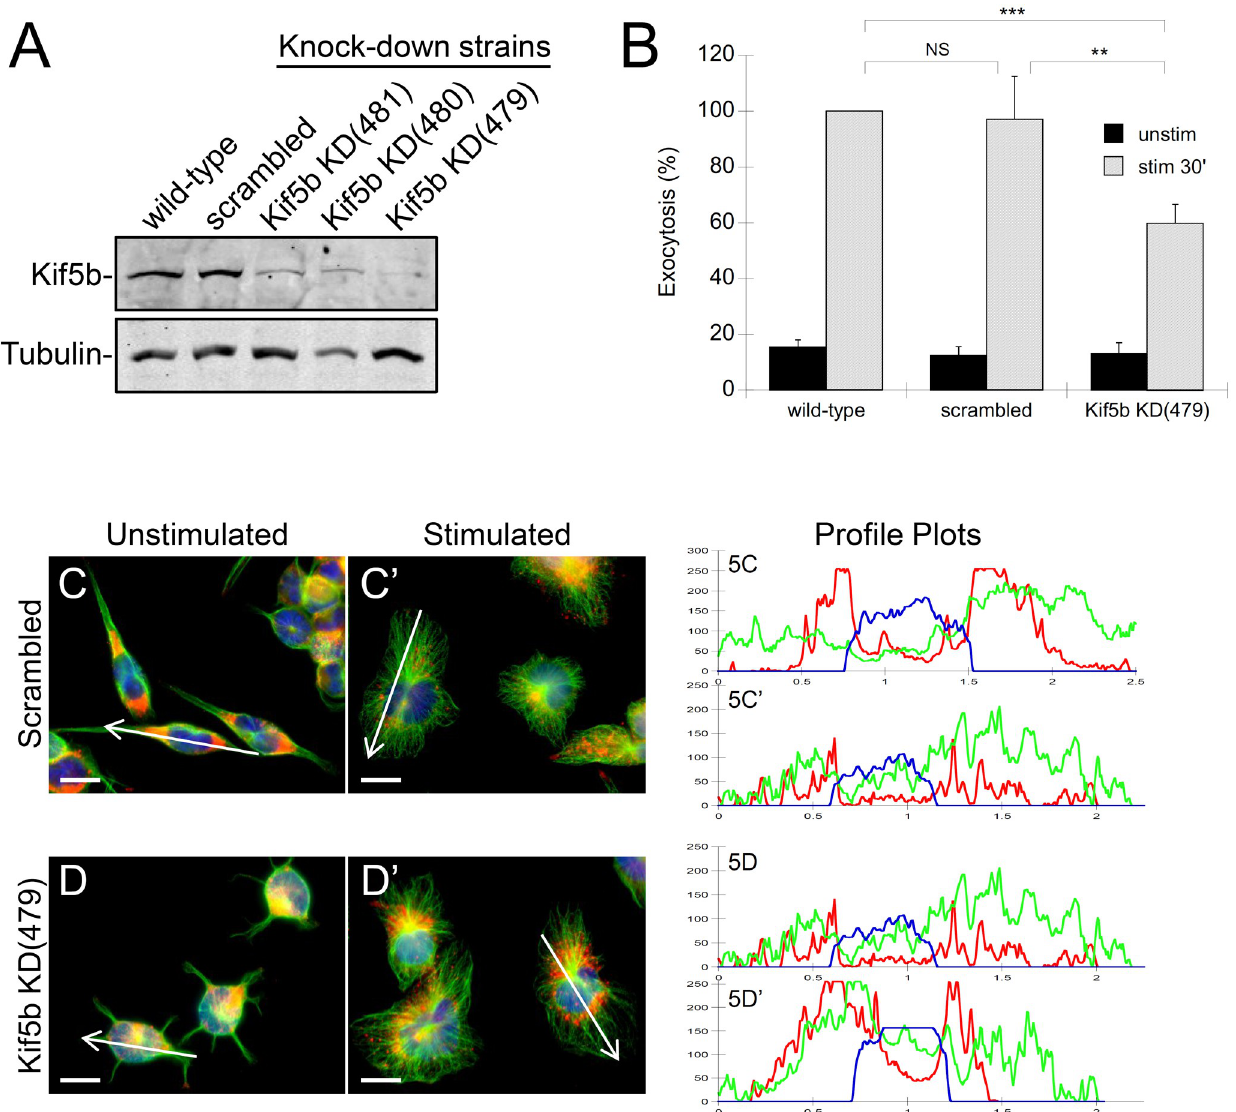
Fig 5. Knock-down of the kinesin-1 heavy chain, Kif5b, inhibits granule translocation to the plasma membrane and exocytosis. A) Comparison of Kif5b levels in different RBL-2H3 knock-down strains. Kif5b knock-down strains were generated with three different specific shRNAs and a non-specific scrambled shRNA as a control. Immunoblot analysis shows reduction in Kif5b in all three strains treated with specific shRNAs, with strain 479 showing the greatest reduction. Tubulin levels remained similar. B) Exocytosis assay of RBL-2H3 strains that were unstimulated ( black bars ), or antigen-stimulated for 30 min ( hatched bars ). The Kif5b knock-down strain showed a significant reduction in exocytosis compared to the scrambled control and wild-type strains. Exocytosis was assayed as the percent β -hexosaminidase released of total, normalized to wild-type stimulated samples. Statistical analysis was by two-tailed unpaired Student’s t -test (NS, not significant; ��� , p = 0.0043; �� , p = 0.029; n = 4). C and D) Immunofluorescence microscopy of RBL-2H3 strains showing the intracellular distribution of CD63+ granules. Control cells ( C ) or Kif5b knock-down cells ( D ) were left unstimulated or antigen-stimulated for 30 min, fixed and stained for nuclei (blue), microtubules (green), or CD63+ granules (red). Scale bar, 10 μ m. Profile plots ( right panels ) show the levels of CD63 + granules distributed in the indicated cross-sections. Kif5b knock-down did not affect microtubule projections after stimulation, however CD63+ granules accumulated in the perinuclear region ( D’ , red ), while in control cells CD63+ granules were distributed across the entire cross-section ( C’ , red ).